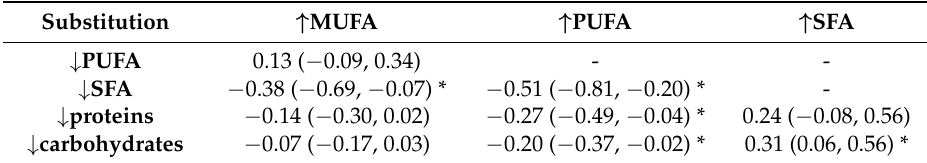
Table 2. Estimated mean changes (95% confidence interval) 1 in body weight (kg) after isocaloric substitutions of 5% energy from MUFA, PUFA, and SFA, proteins, and